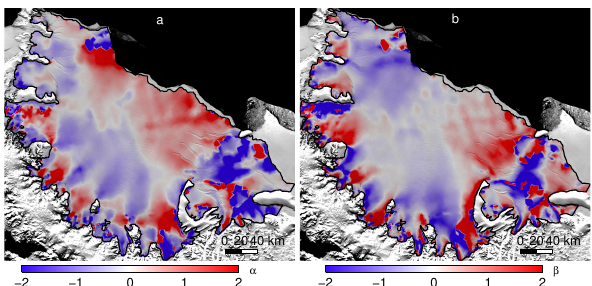
Fig. 3. (a) Calculated mean basal melting rates for the period 1979– 2010 (positive for melting, negative for freezing) in meters of ice equivalent per year; (b) depth-integrated ice temperature. Both pan- els plotted over 2009 MOA